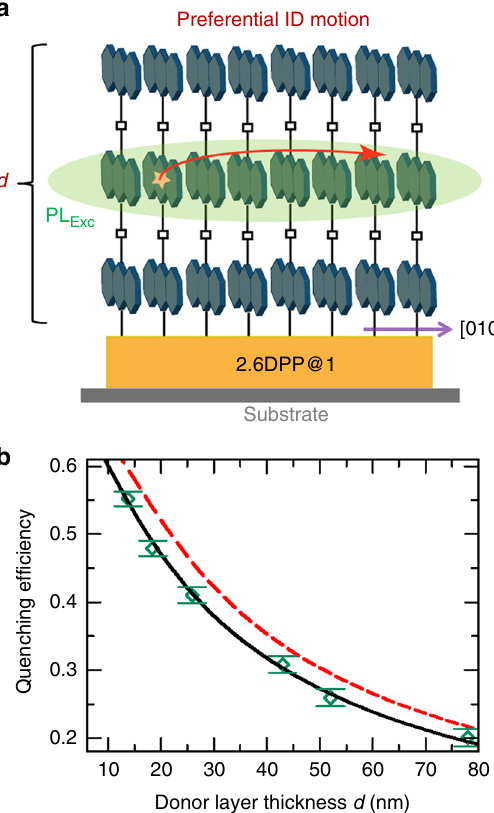
Fig. 5 Energy transport in bilayer heterostructure. a Schematic illustration of the bilayer structure and the anisotropic energy transfer path of PL Exc state. b Total quenching ef fi ciencies (shown as green) extracted from the PL decay are shown against the donor layer thickness ( d ) on top of the 2.6DPP@1; the broken red line is the simulation result assuming isotropic diffusion with FRET hops toward the acceptor and the black solid line is a simulation result considering anisotropic model (only FRET radius of 5.5 nm toward DPP, no diffusion along the sheets) (Supplementary Fig. 19). The error bars are determined by propagating the uncertainties in the fi ts shown in Supplementary Fig.